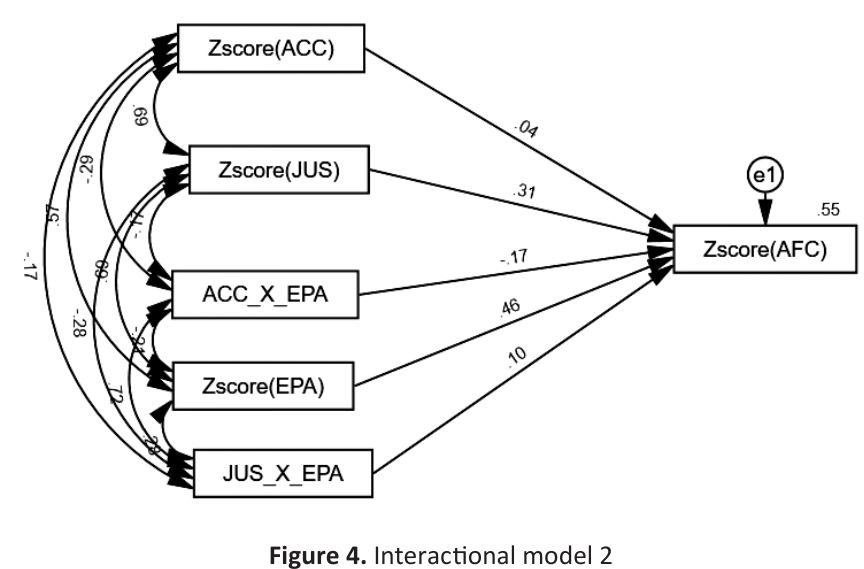
Figure 4. Interactional model 2